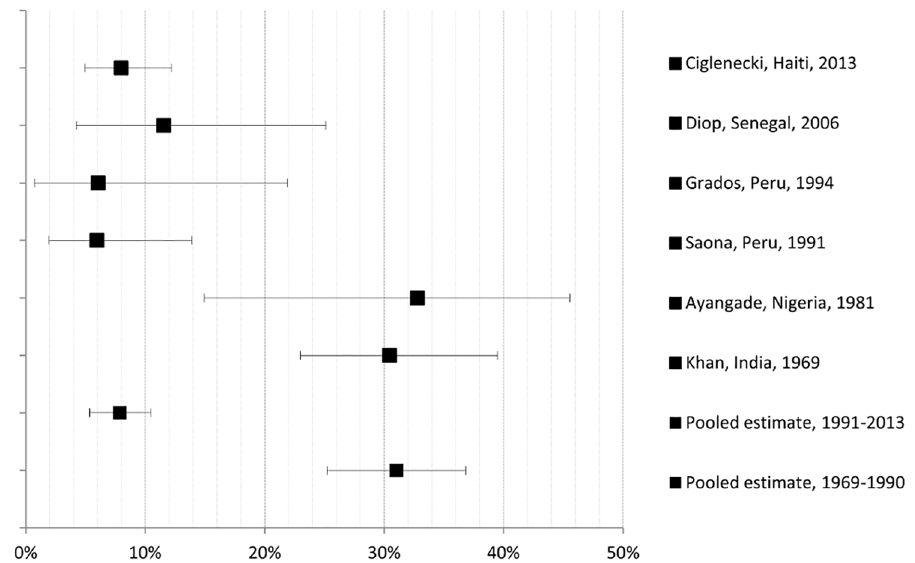
Fig 2. Fetal death rate (all trimesters) with maternal cholera: study and pooled estimates per 100 pregnancies with 95% confidence intervals.